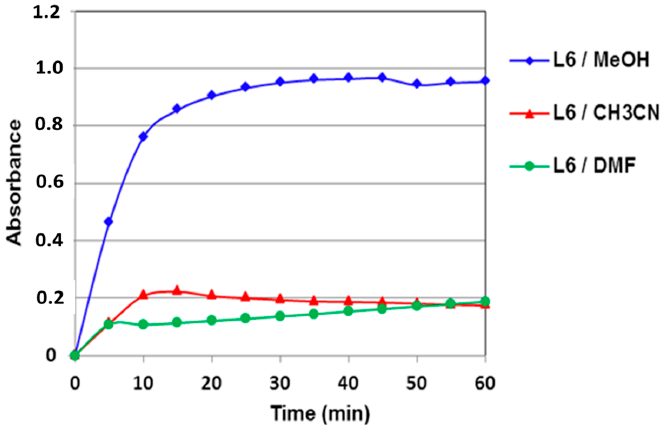
Figure 8. Catechol oxidation in different solvents and in the presence of formed L6 copper complexes (1 Equivalent of L 6 for 1 Equivalent of Cu(CH 3 COOH) 2 ).